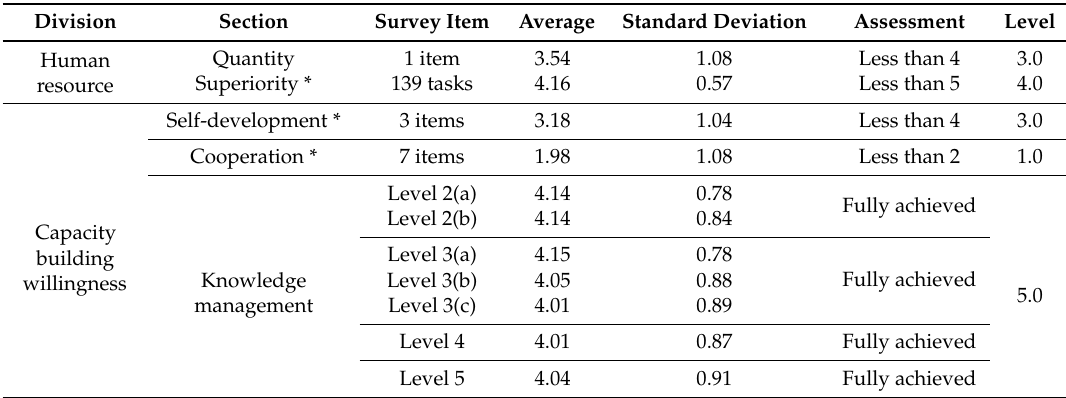
Table A1. Survey results to assess individual competitiveness—Department